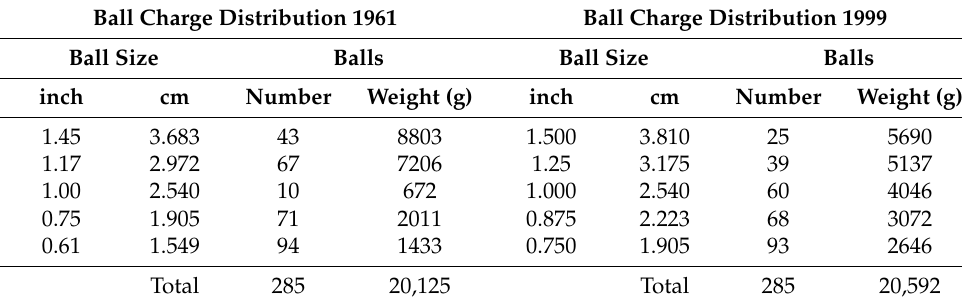
Table 1. Evolution of the ball grinding charge distributions proposed by